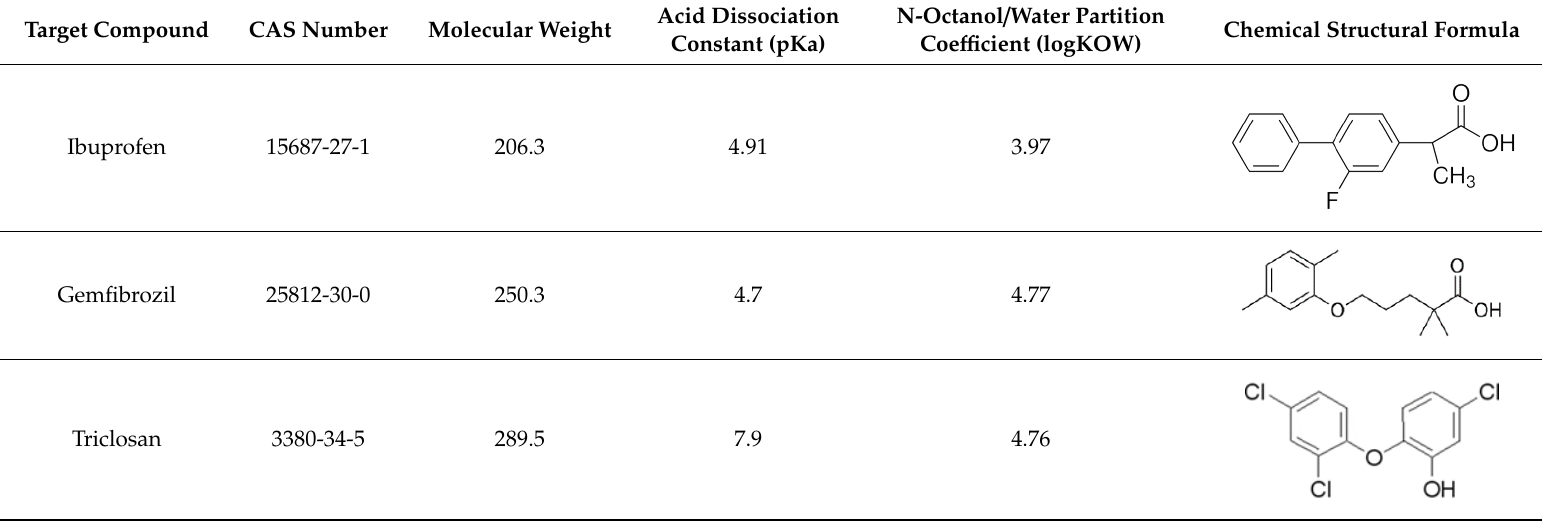
Table 1. Characteristics of the organic compounds.